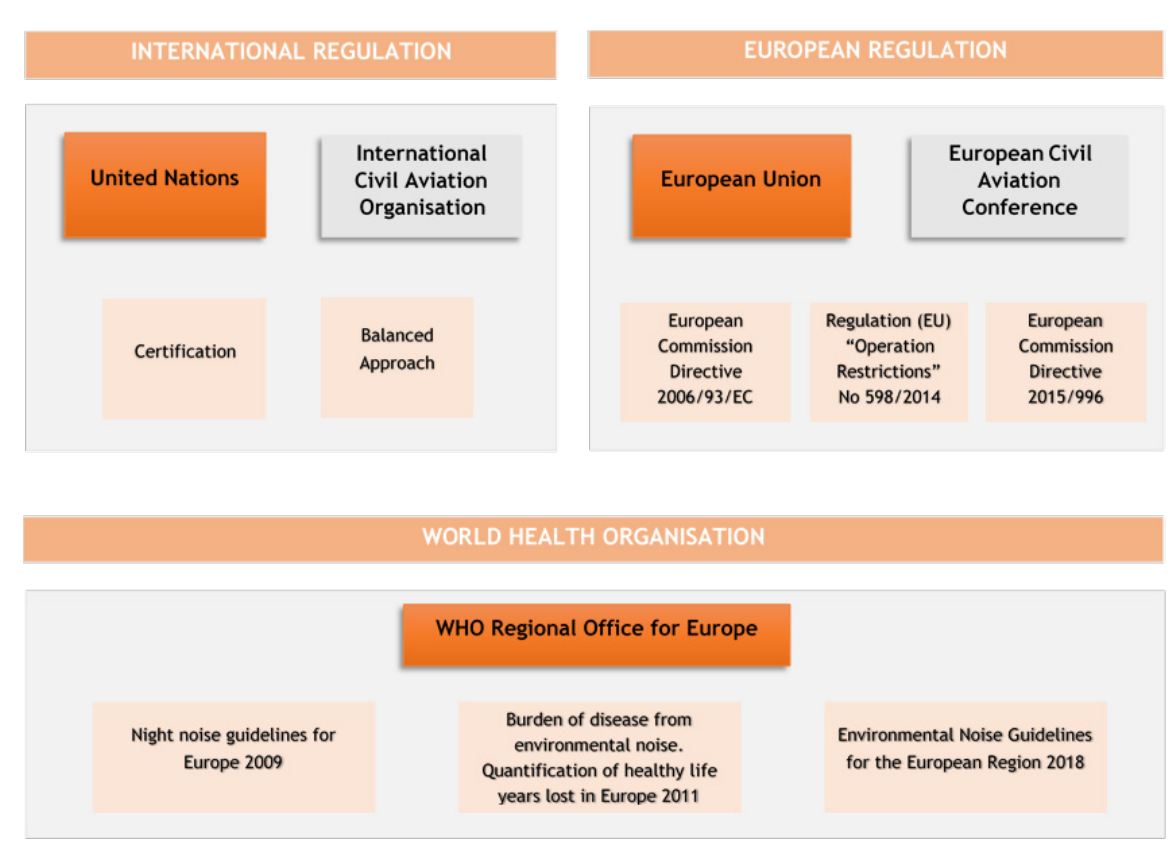
Figure 9: Noise regulation & WHO